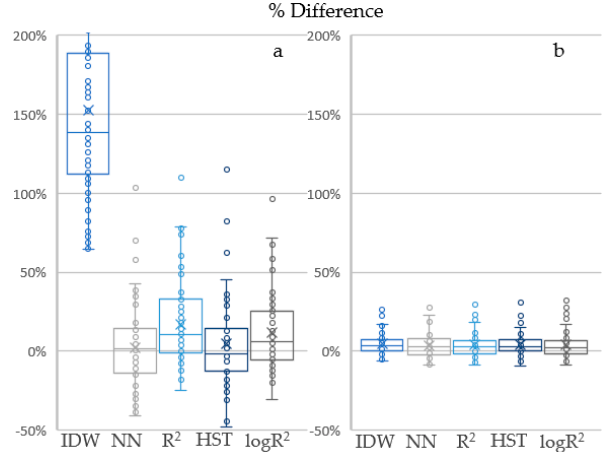
Figure 6. Results of the number of wet days comparison between the filled-in data using different methods and the validation data ( a ) after the fill-in and ( b ) after the fill-in correction using quantile mapping. Different colors serve only for artistic purposes.